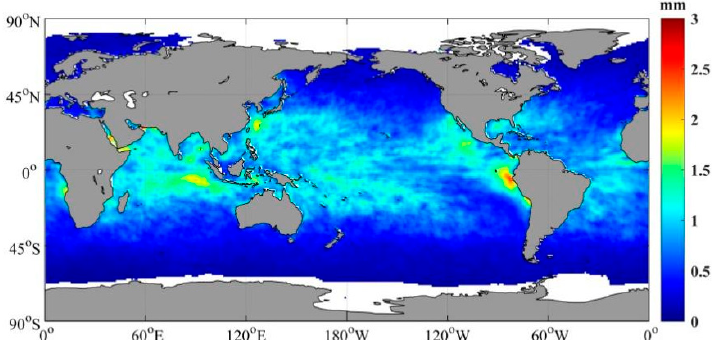
Figure 9. Global distributions of the monthly standard deviation between the fusion product and RSS product during 2016–2018. First, the monthly water vapor of each month from 2016 to 2018 was obtained by using the fused water vapor data. Then, the calculated monthly water vapor data were compared with the monthly water vapor data of the RSS. Finally, the standard deviation was obtained by using the monthly water vapor data of 36 months.